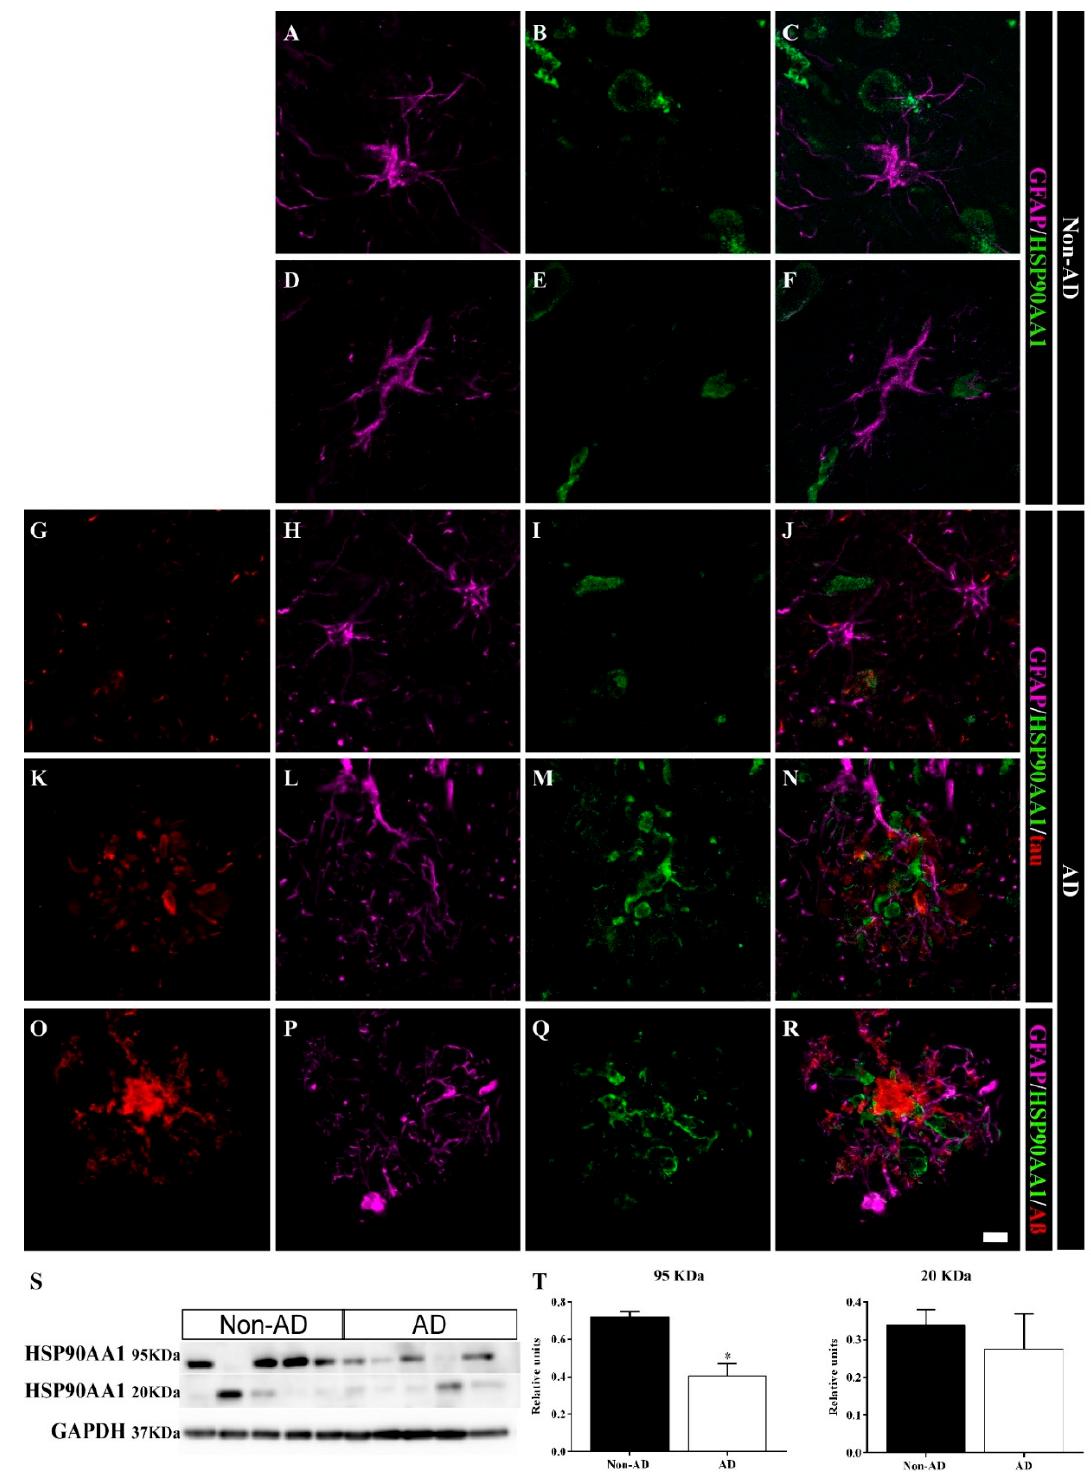
Figure 8. HSP90AA1 accumulates within plaques in the human HIPP. Confocal images of GFAP ( violet ), HSP90AA1 ( green ) and tau or A β ( red ) expression in the CA1 region in non-AD ( A – F ) and AD ( G – R ) samples. In AD cases, HSP90AA1 aggregated in plaques ( N , R ), and was in close contact with the A β plaque core ( R ). Astrocytes did not express HSP90AA1 in non-AD ( A – F ) or AD ( K – O ) samples. ( S , T ) HSP90AA1 expression throughout the whole human HIPP was evaluated by WB (the graph shows the mean ± SEM, * p value < 0.05). Scale bar = 10 µ